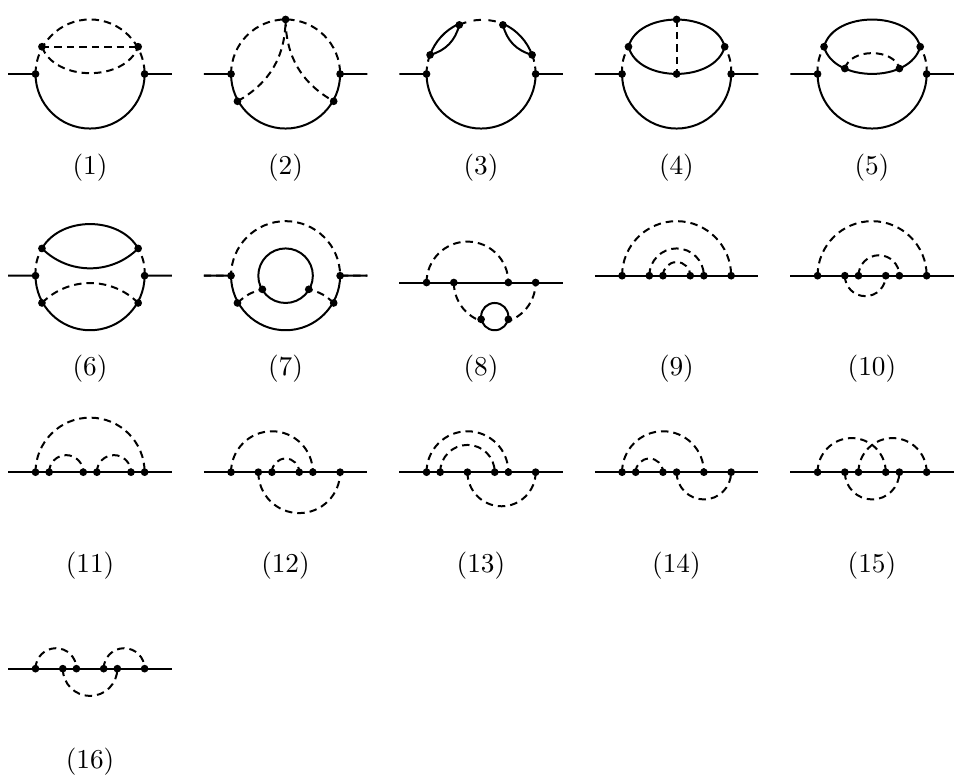
Figure 2 . Three-loop diagrams giving contributions to the fermion field anomalous dimensions, containing Yukawa and quartic interactions of fermions (solid lines) and scalar fields (dashed